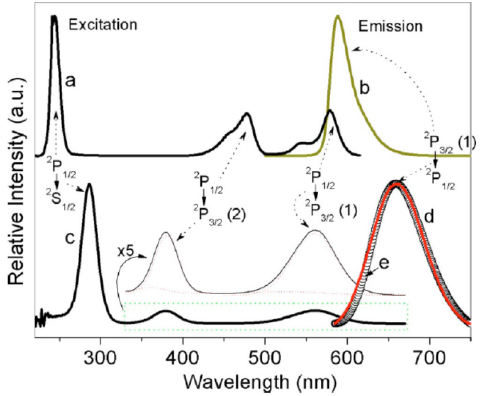
Figure 18. Excitation and emission spectra of SrB 4 O 7 :0.5%Bi ( a ) em = 630 nm; ( b ) ex = 245 nm and SrB 6 O 10 :0.5%Bi ( c ) em = 690 nm; ( d ) ex = 380 nm. Reprinted from [220] with permission.